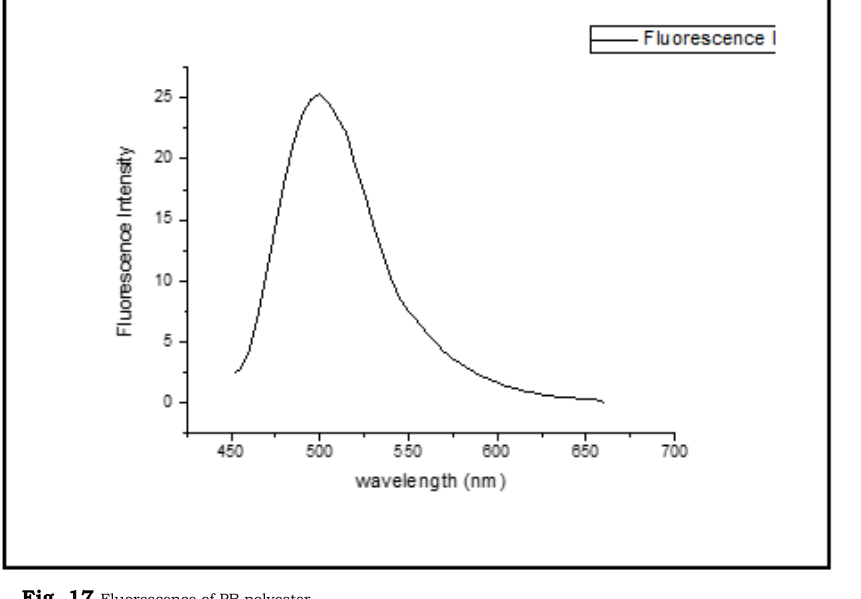
Fig. 17 Fluorescence of PB polyester